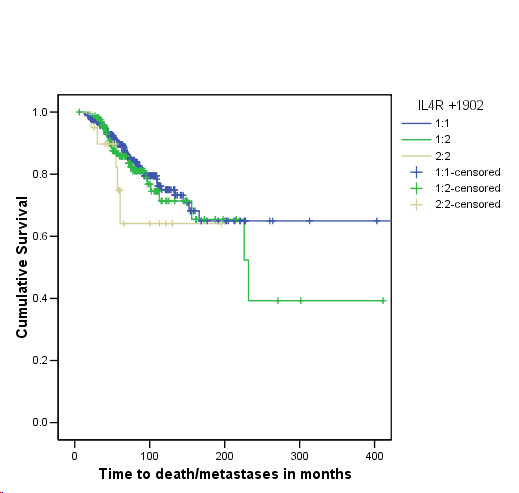
shows the time to death or metastases in invasive breast cancer for the genotypes of the IL4R +1902 polymorphism. Log Rank test statistic = 2.07; df = 2; p = 0.35 (n = 528).